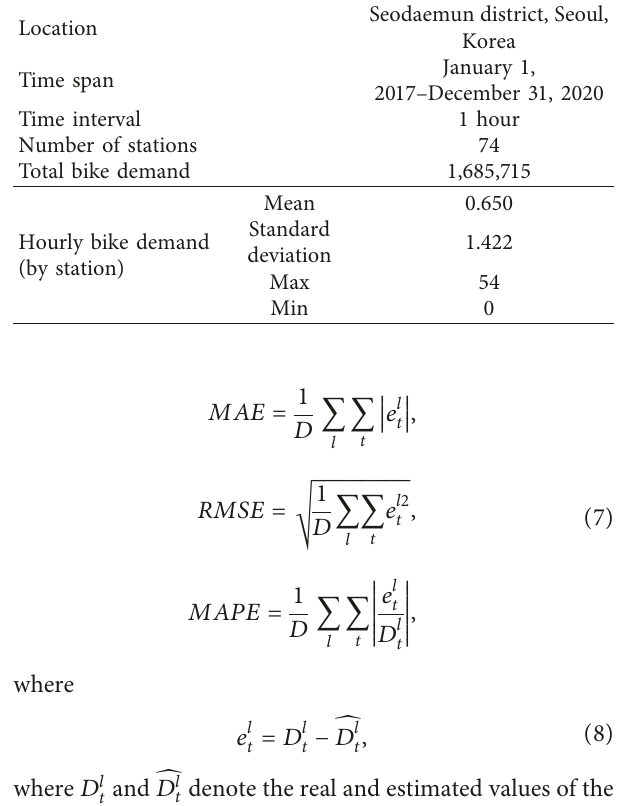
Figure 2: Location of bike-sharing station in Seodaemun district, Seoul, Korea. Table 1: The description of sharing bike demand